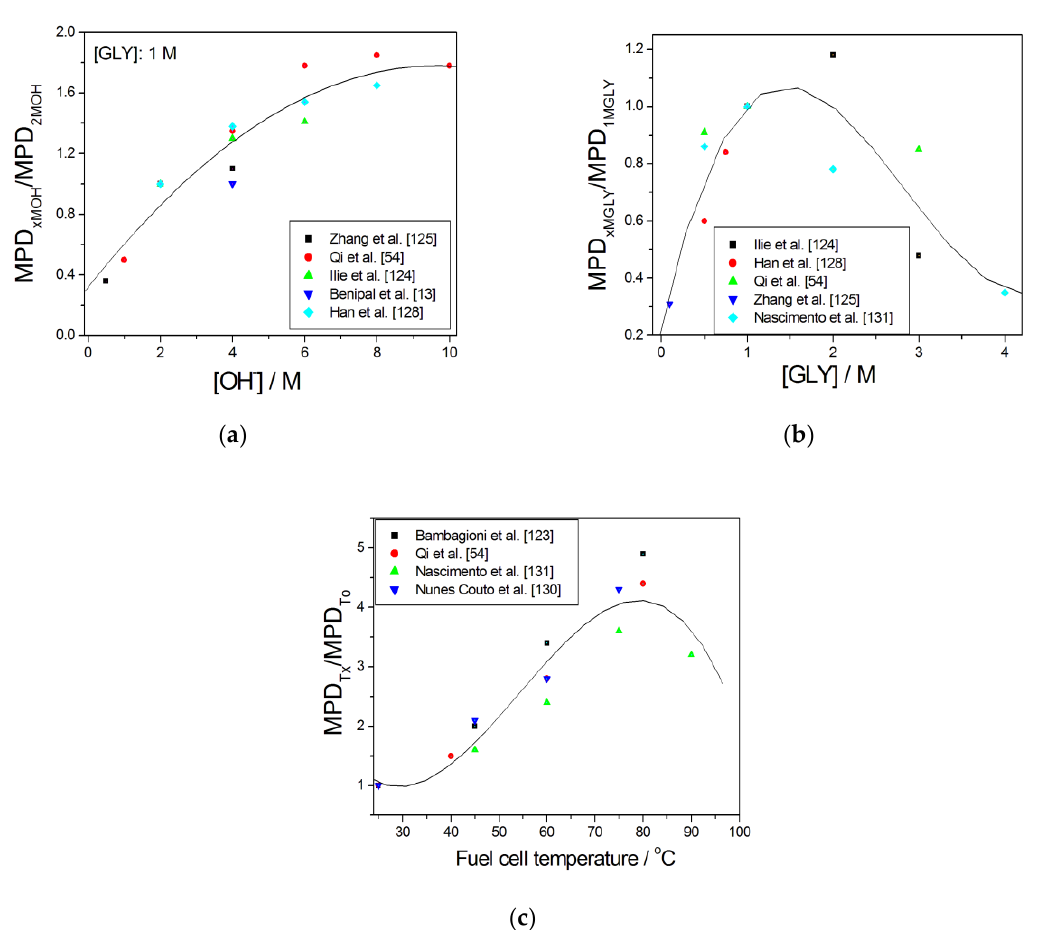
Figure 8. Dependence of the maximum power density of ADGFCs on some operational parameters: ( a ) [OH − ], ( b ) [GLY] and ( c ) temperature. ( a ) [OH − ], ( b ) [GLY] and ( c )